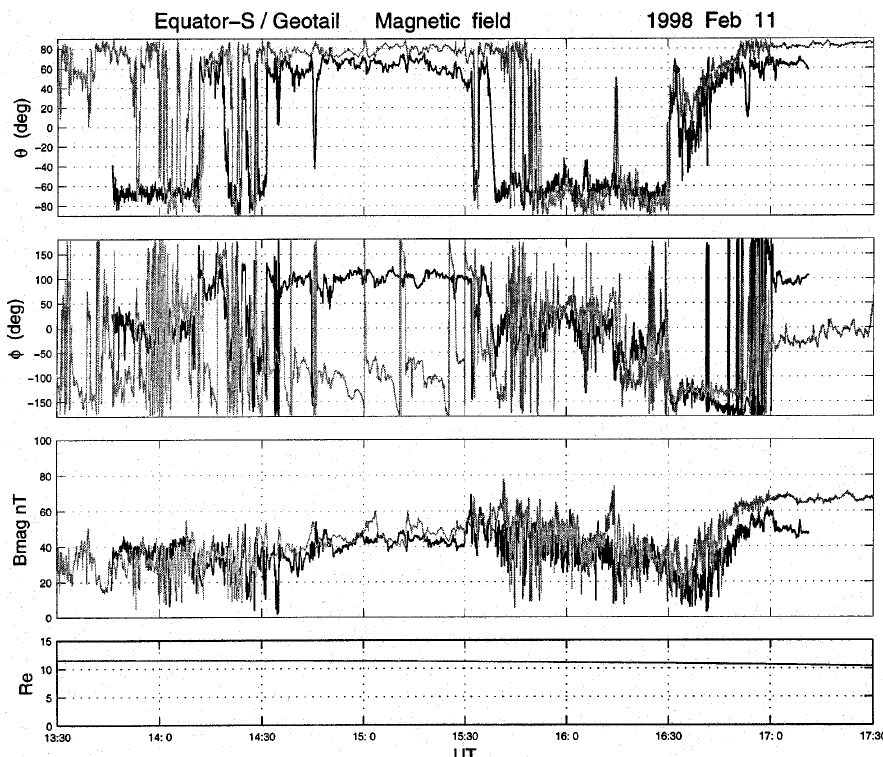
Fig. 11. Comparison of Geotail ( light trace ) and Equator-S magnetic field data, for the event in